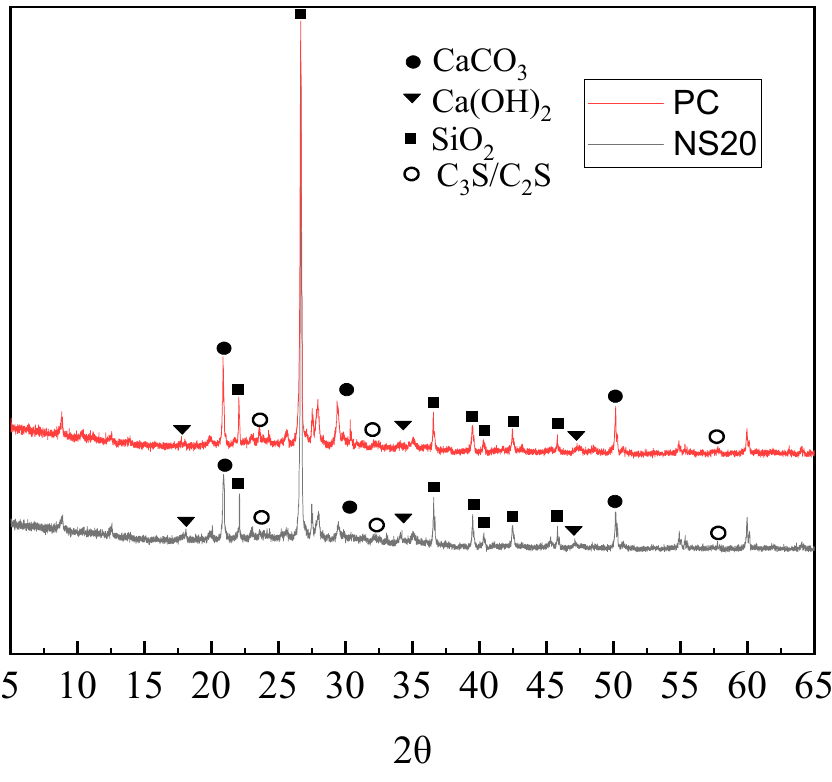
Figure 8. Concrete XRD pattern (tensile stress level is 0.6; carbonation age is 28 days).